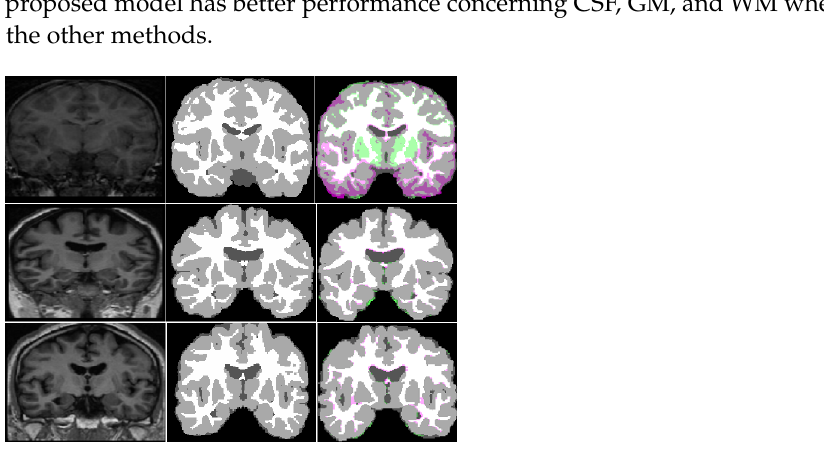
Figure 2. Segmentation results on IBSR18 dataset: first column, original image; second column, ground truth; and third column, segmentation result fused on ground truth. Table 2. Result comparison with state-of-the-art methods on IBSR18 dataset only in terms of